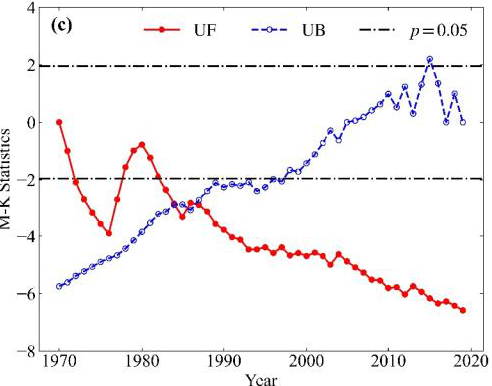
Figure 1. ( a ) Inter-annual variation, ( b ) Hurst index and ( c ) M–K mutation test of the annual SD in China (UF and UB refer to the positive sequence curve and reverse sequence curve, respectively; the same is true below).